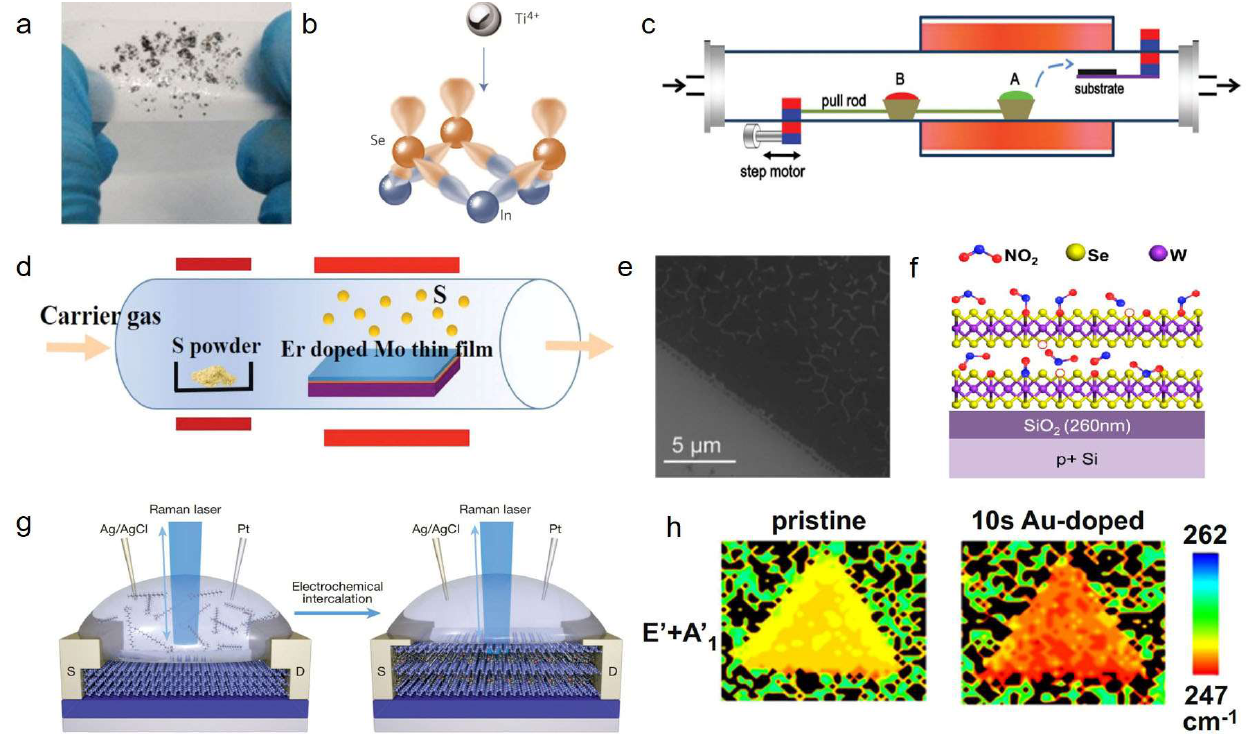
Figure 4. Various methods to synthesize 2D doped materials. ( a ) Photo of exfoliated TMDCs alloy flakes. Reproduced with permission from [31]. ( b ) Atomic layers of n-type InSe react with Ti 4+ to form planar p-type [Ti 4+ n (InSe)] coordination complexes. Reproduced with permission from [75]. ( c ) Schematic of a common vapor growth experimental set-up. Reproduced with permission from [76]. ( d ) Schematic diagram of sulfurization of Er-doped Mo thin film predeposited by sputtering. Re- produced with permission from [77]. ( e ) Schematic of pristine MoS 2 ( top ) and vacancy doped MoS 2 annealed at 250 ◦ C ( bottom ). Reproduced with permission from [78]. ( f ) Schematic of NO x chemisorption process. Reproduced with permission from [60]. ( g ) In situ electrochemical-optical measurement platform to monitor electrochemical intercalation process. Reproduced with permission from [79]. ( h ) Raman mappings of the pristine and Au-decorated WSe 2 . Reproduced with permission from [80].